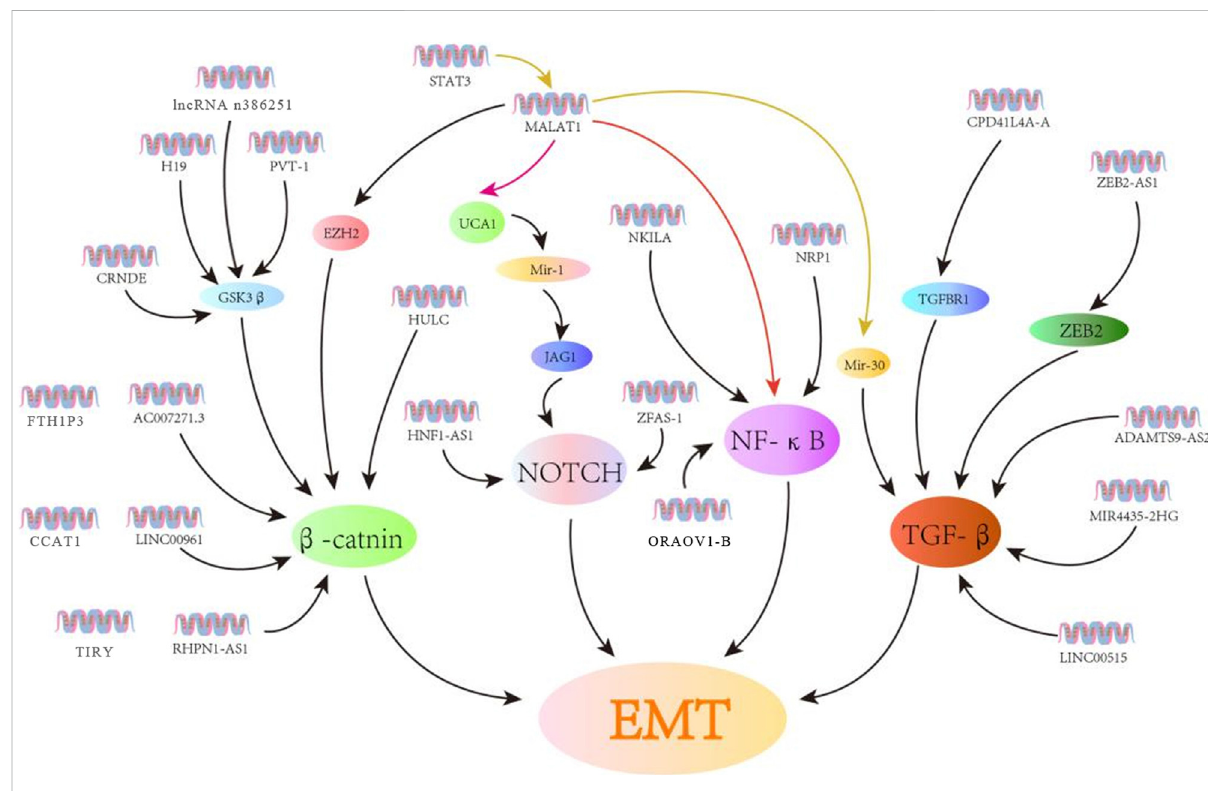
FIGURE 2 LncRNAs control EMT induction in OSCC cells through various signaling cascades. Herein, the lncRNAs associated with EMT are related to the Wnt, Notch, NF- κ B, and TGF- β signaling